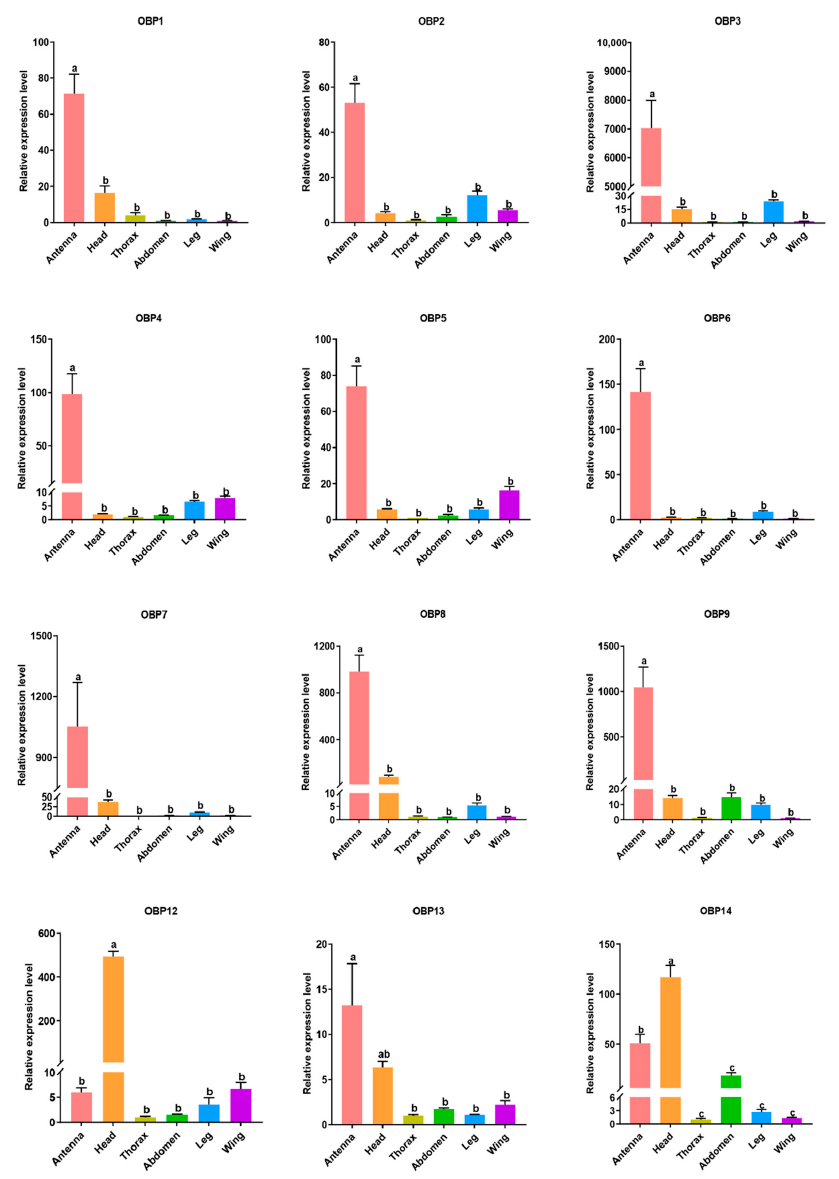
Figure 5. Relative expression levels of OBPs in different tissues of N. cincticeps analyzed by qRT-PCR. Four biological replicates were conducted for each experiment. The relative quantification was calculated using the comparative 2 −ΔΔ Ct method. The comparative analysis of each OBP genes among various tissues was determined using a one-way tested analysis of variance (ANOVA), followed by Tukey’s multiple range test ( p < 0.05). Different lowercase letters indicate significant differences be- tween different tissues. The values were presented as the mean ± standard error.